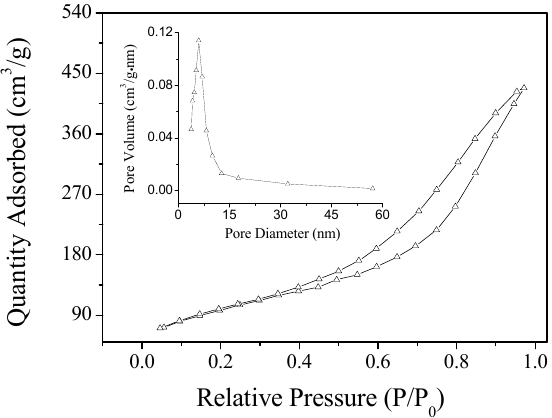
Figure 3. N 2 adsorption/desorption isotherms and pore size distribution of the Dop-TAMS. Figure 3. N